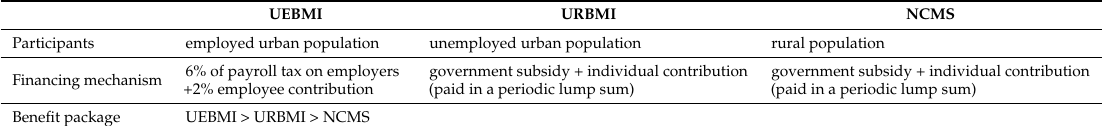
Table A1. Overview of the three public health insurance schemes in